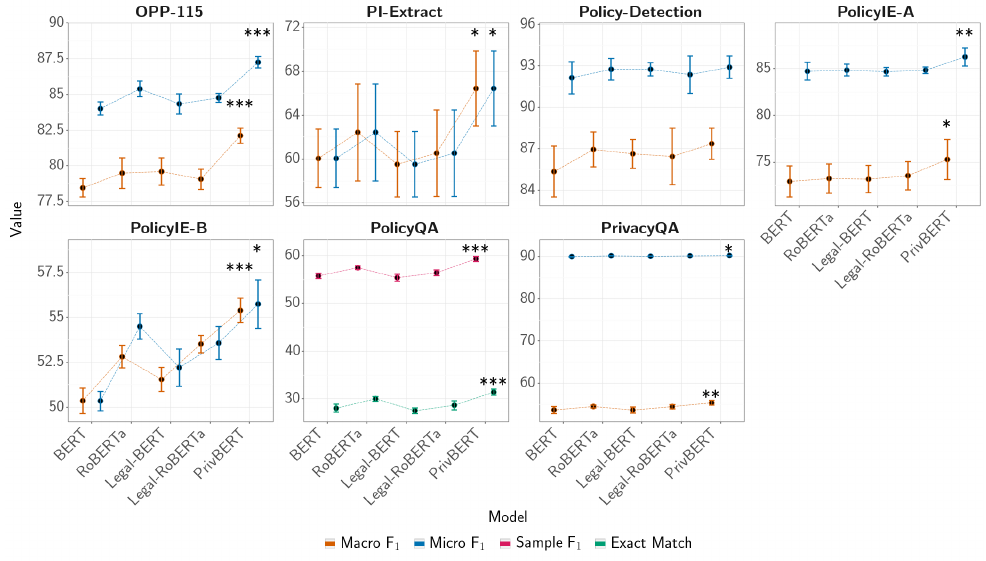
Figure 3. Test-set results of the PrivacyGLUE benchmark where points indicate mean performance and error bars indicate standard deviation over 10 random seeds; *** implies p ≤ 0.001 , ** implies 0.001 < p ≤ 0.01, * implies 0.01 < p ≤ 0.05 given an alternative hypothesis that PrivBERT has